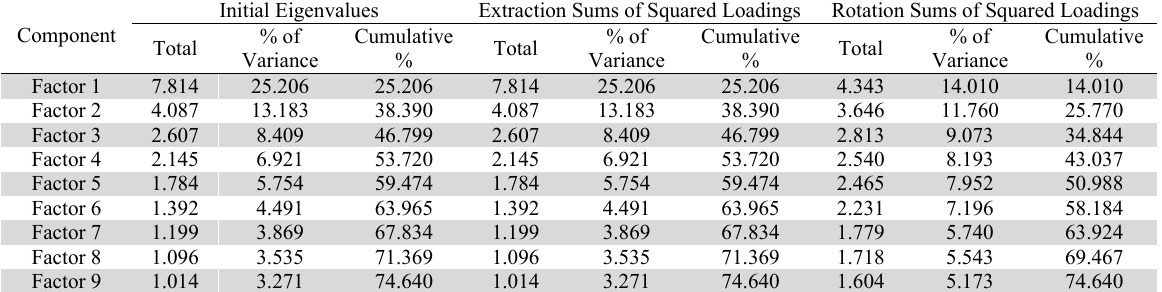
The summary of PCA for factors influencing on exports Component